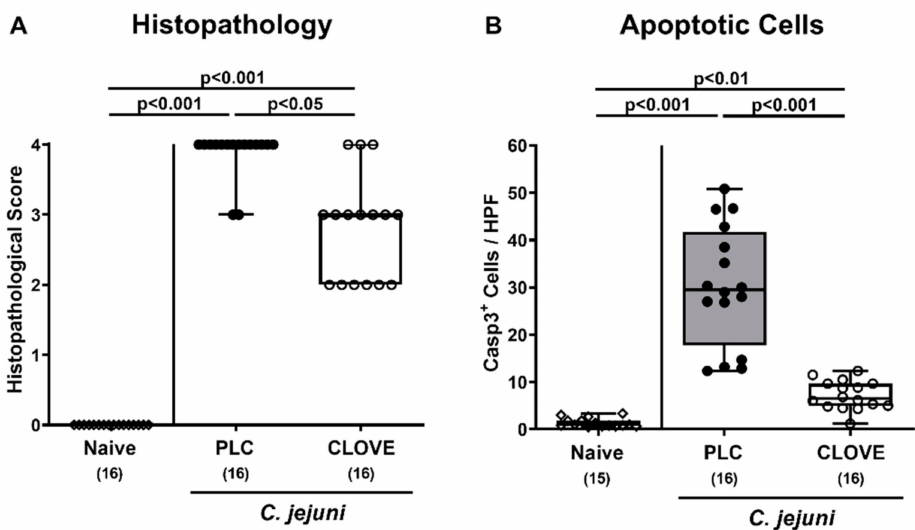
Figure 4. C. jejuni induced microscopic inflammatory sequelae following clove EO treatment of infected IL-10 − / − mice. Microbiota-depleted IL-10 − / − mice were perorally infected with C. jejuni strain 81-176 on day (d) 0 and d1. From d2 until d6 post-infection (p.i.), mice were perorally challenged with clove EO or received placebo (PLC) via drinking water. On day 6 p.i., ( A ) colonic histopathological changes were quantified in hematoxylin and eosin-stained colonic paraffin sections by using histopathological scores. Furthermore, ( B ) the average numbers of apoptotic colonic epithelial cells were assessed microscopically from six high power fields (HPF, 400 × magnification) per animal in paraffin sections positive for cleaved caspase3 (Casp3 + ). Box plots indicate the 75th and the 25th percentiles of the median (black bar within box). Naive mice were included as negative control animals. The total range, significance levels ( p values) determined by the ANOVA test with Tukey post-correction or by the Kruskal-Wallis test and Dunn’s post-correction and the total numbers of analyzed mice (in parentheses) are given. Definite outliers were removed after being identified by the Grubb’s test ( α = 0.001). Data were pooled from four independent